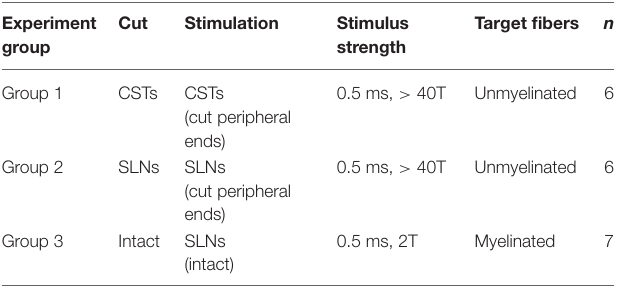
TABLE 1 | Summary of the three experimental